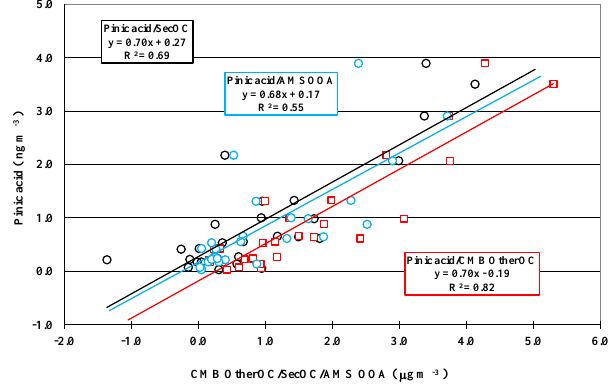
Figure 6. Secondary component comparison at NK showing re- lationships between pinic acid concentrations and estimated sec- ondary OC from the elemental carbon tracer method (Sec-OC) and the CMB model (Other-OC), and with the AMS OOA factor.